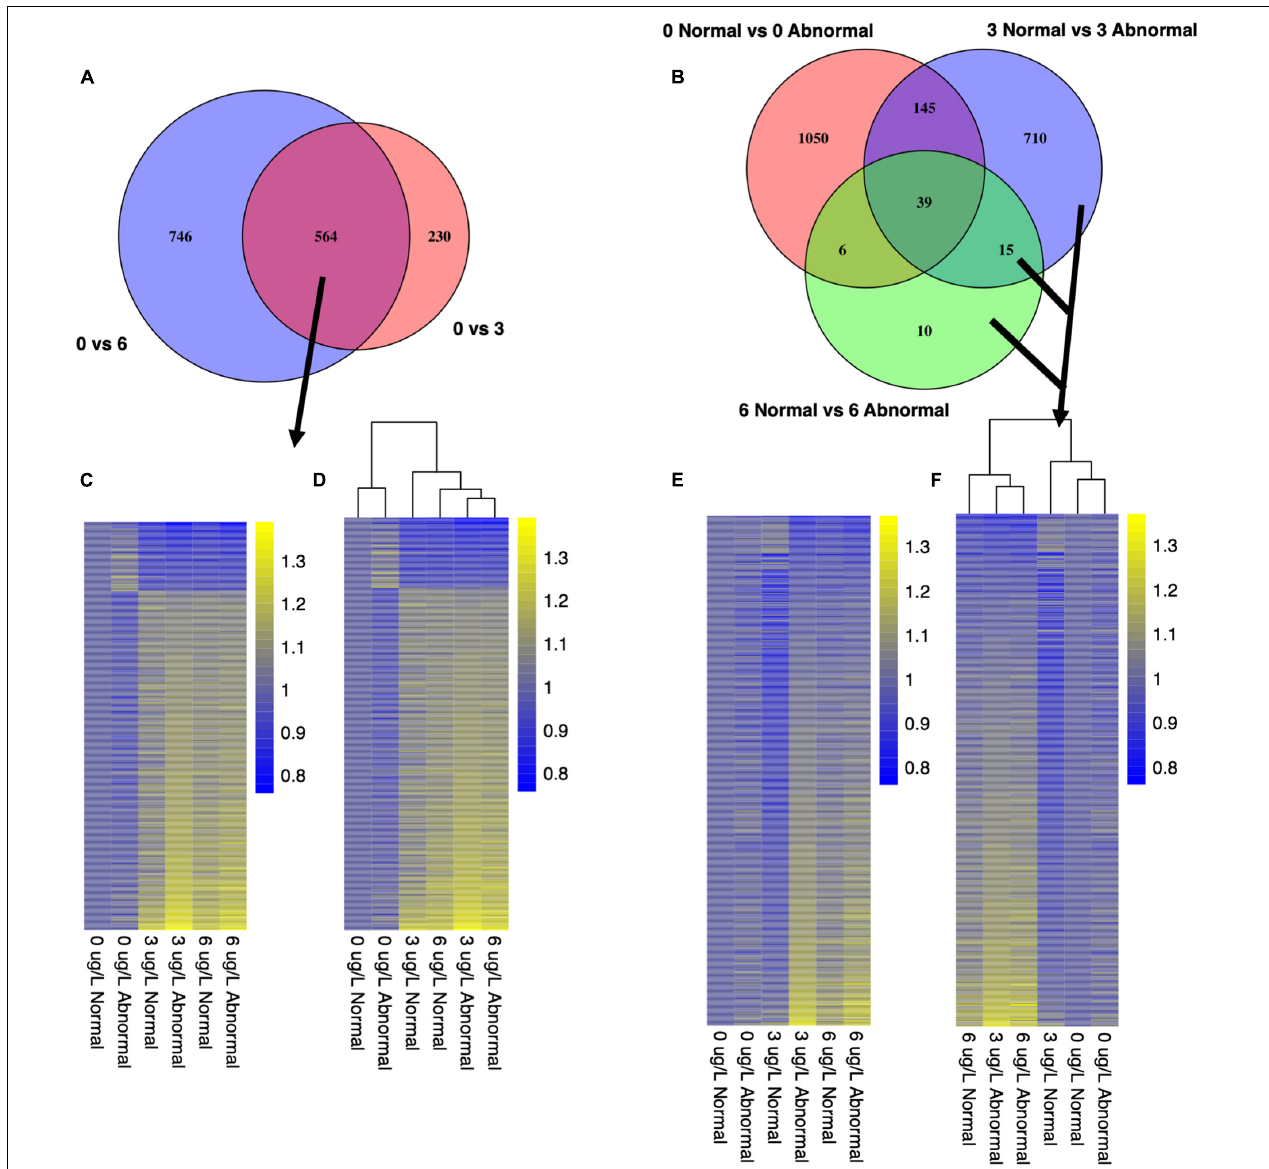
FIGURE 7 | Venn diagrams illustrate gene sets that were chosen as pooled larval markers of exposure (A) and markers of effect (B) . Heatmaps depict expression patterns of shared markers of exposure (C,D) and all markers of effect (E,F) . Counts were transformed using Variance Stabilizing Transformation in DESeq2. Each column represents the control-normalized mean count for all replicates in a given condition. Yellow coloration represents higher expression values, and blue coloration represents lower expression